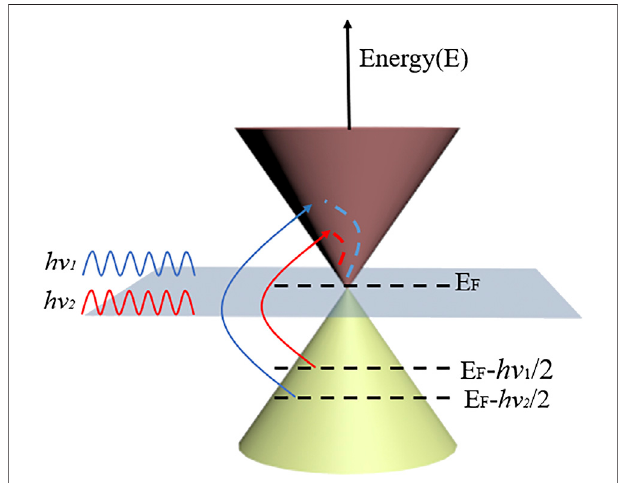
FIGURE 3 | Diagram of graphene ’ s band structure and photon absorption.